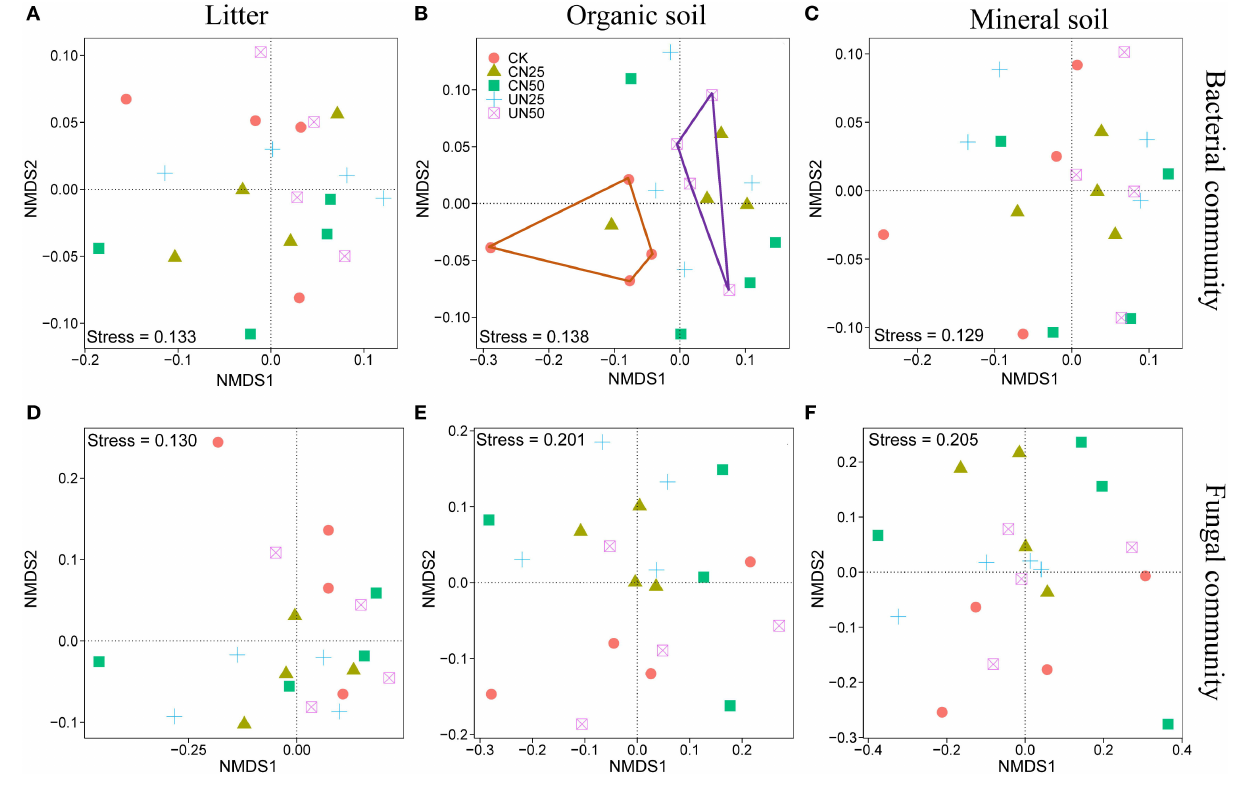
FIGURE 3 | Nonmetric multidimensional scaling (NMDS) analysis based on the Bray–Curtis distance for the bacterial (A–C) and fungal (D–F) community compositions under different N addition treatments in different soil